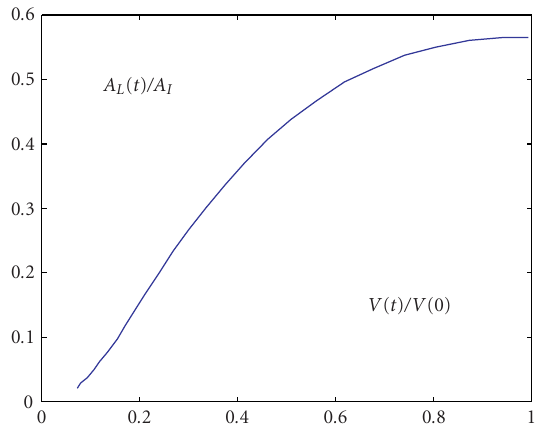
Figure 3.16. Correlation between the normalised two-dimensional liquid foam area and the three- dimensional liquid foam volume fraction. The process starts in the upper right